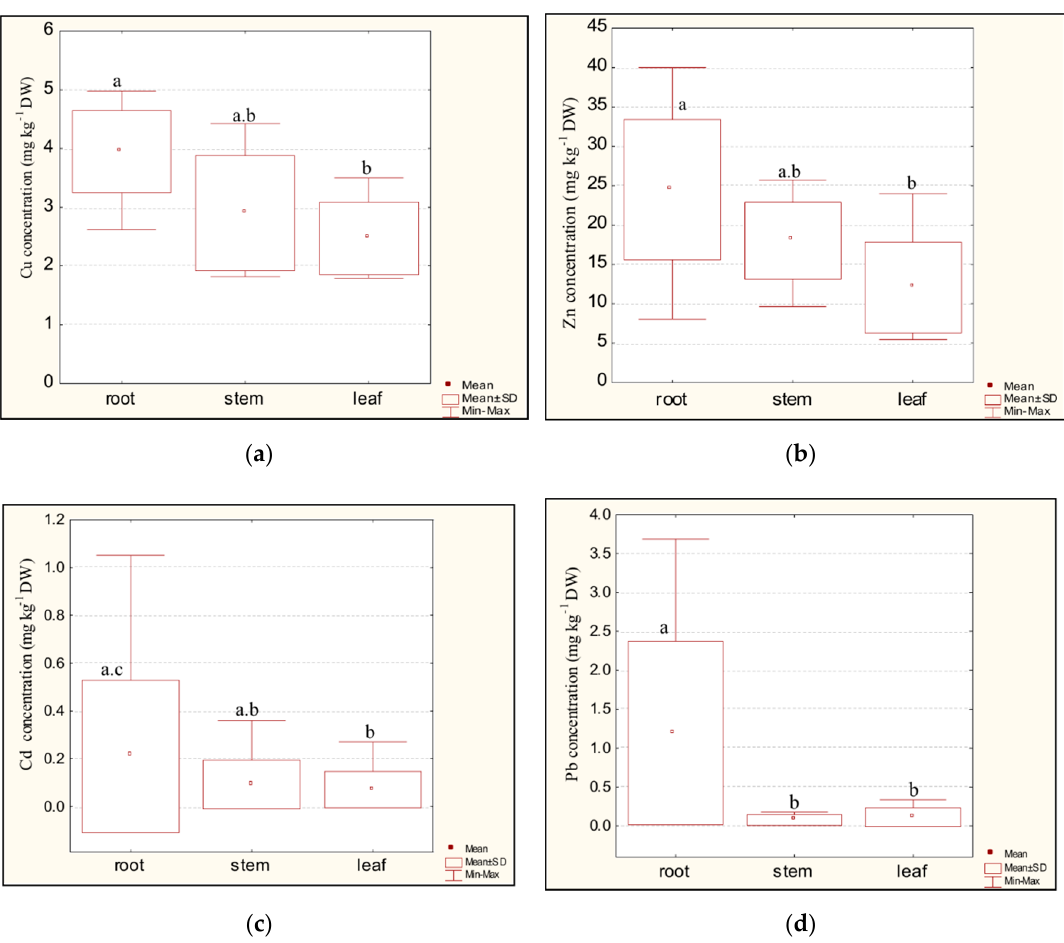
Figure 2. Box-plot graphs of Cu ( a ), Zn ( b ), Cd ( c ), and Pb ( d ) concentrations in the individual parts of Trapa natans L. at nine sampling locations (box-plot boundaries indicate the average value, standard deviations, and minimum and maximum value). The statistically significant differences among groups according to the post hoc Tukey’s test ( p < 0.05) are indicated by the different letters.